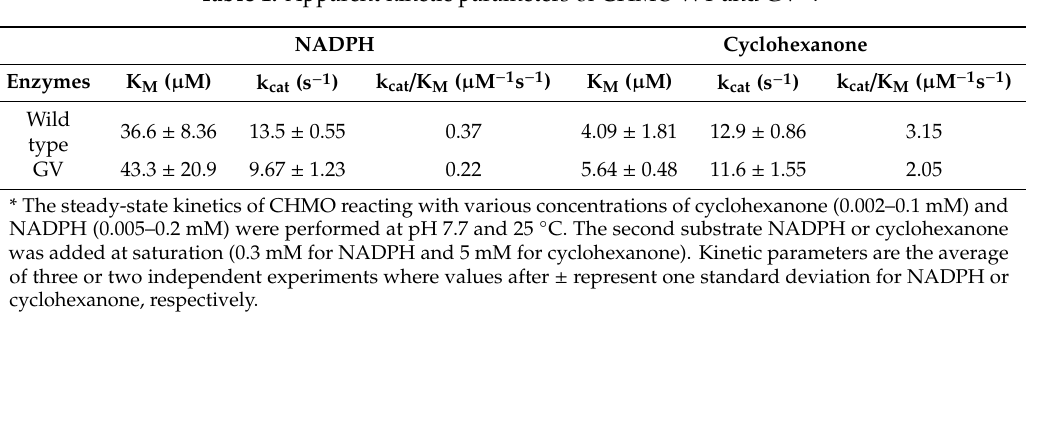
Figure 2. Analysis of CHMO GV with improved thermostability. ( A ) At 42 ◦ C, CHMO GV, but not wild type (WT), restores growth of the selection strain MX203; ( B ) CHMO GV retains higher percentage activity loss after incubation at 40 ◦ C and 45 ◦ C. Values are an average of two or three replicates, and the error bars represent one standard deviation. Table 1. Apparent kinetic parameters of CHMO WT and GV *.